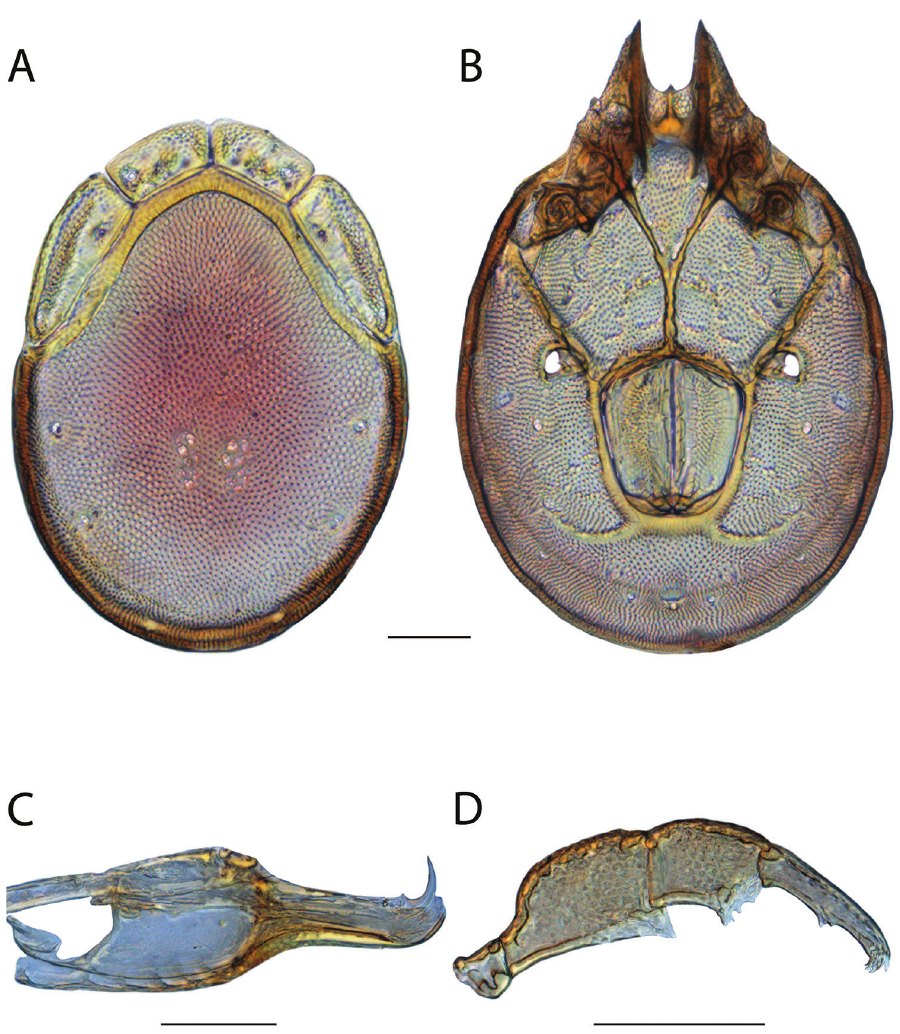
Figure 173. Torrenticola oliveri sp. n. female: A dorsal plates B venter (legs removed) C subcapitulum D pedipalp (setae not accurately depicted). Scale = 100